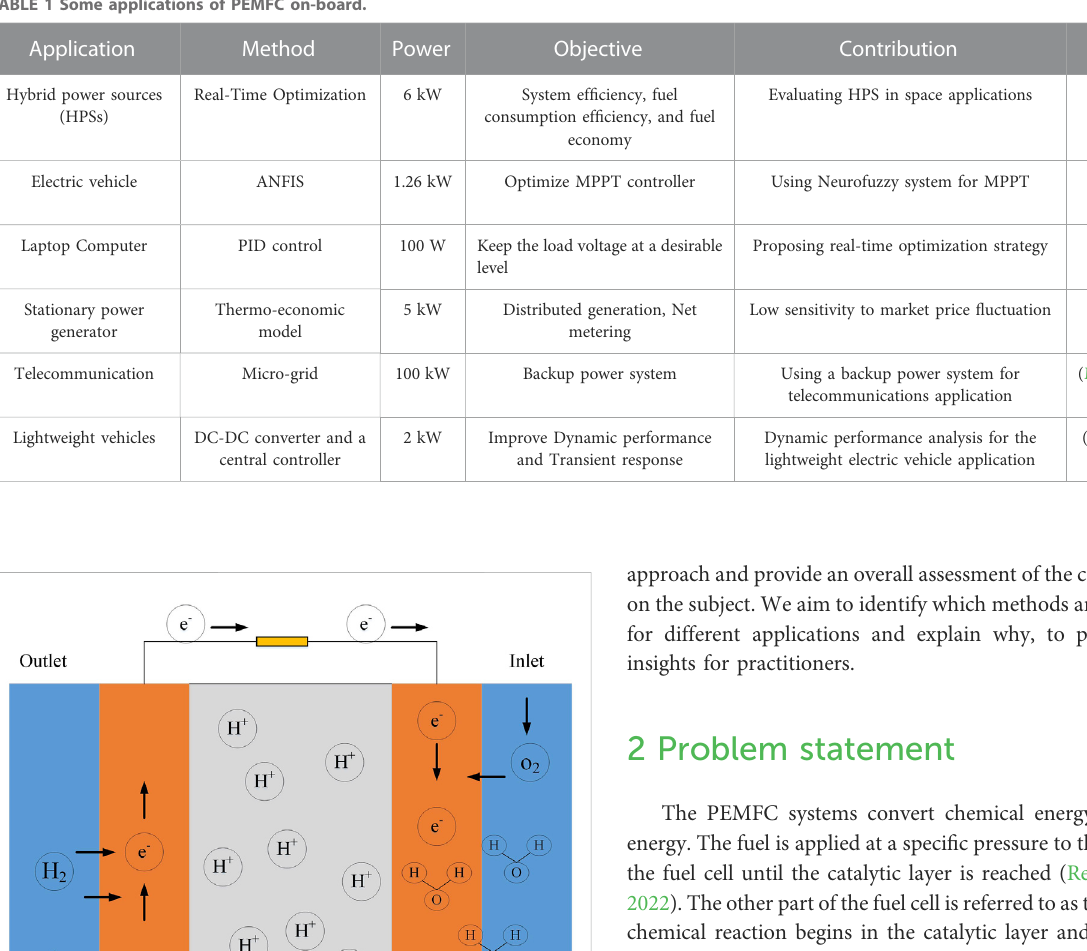
TABLE 1 Some applications of PEMFC on-board.